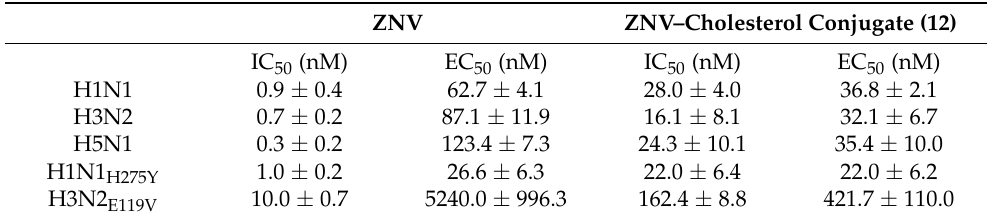
Table 1. IC 50 values for NA enzyme inhibition and EC 50 values for the inhibition of viral replication of compounds ZNV and ZNV–cholesterol conjugate ( 12 )